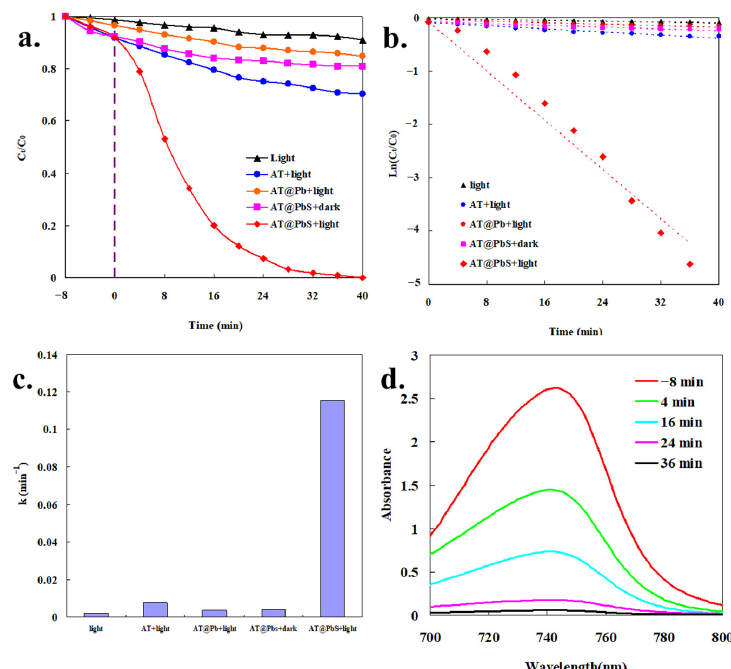
Figure 8. ( a ) The photocatalytic performance of different systems, ( b ) the apparent fitting findings using the first-order model, ( c ) the constants of first-order reactions for MB (methylene blue), ( d ) UV-visible absorption spectra of MB (methylene blue) solution degraded by AT@PbS+light (attapulgite/lead sulphide composite +light).